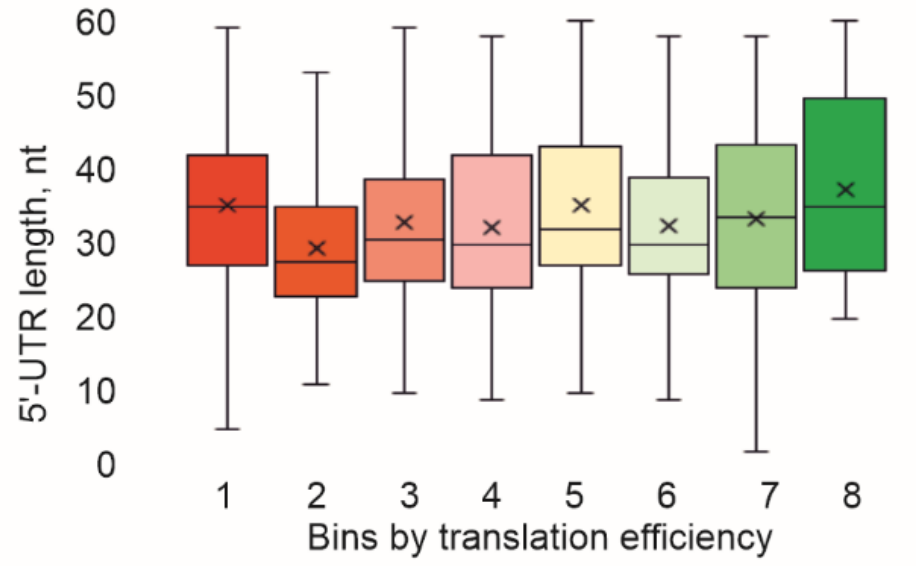
Figure 3. Influence of 5′ -UTR length on translation efficiency. Shown is a distribution of the 5′ -UTR length in the bins sorted using translation efficiency. Quartile ranges are shown as solid bars (25% to 50%) and thin lines (0% to 100%). Horizontal line corresponds to median, while cross to the aver- age.